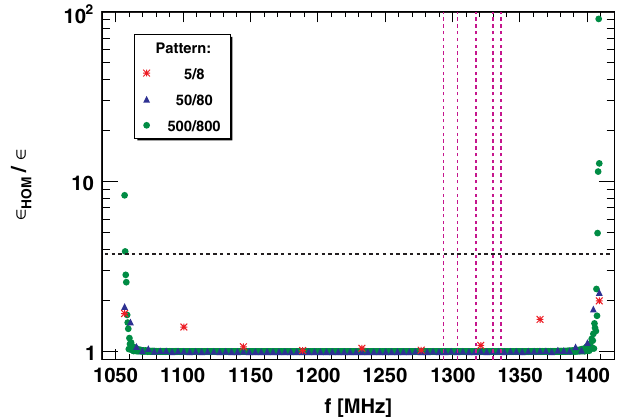
FIG. 15. Longitudinal phase space increase against the HOM frequency, where a HOM falls on a chopping machine line at ¼ 10 7 for different chopping patterns. nominal current and Q ex The rf induced growth (black dashed line) is indicated and the found monopole modes (violet dashed lines) in the investigated i shifted, h I i ¼ frequency range. Settings: chopping, h f b HOM 40 mA , N ¼ 1 , see Table VI.